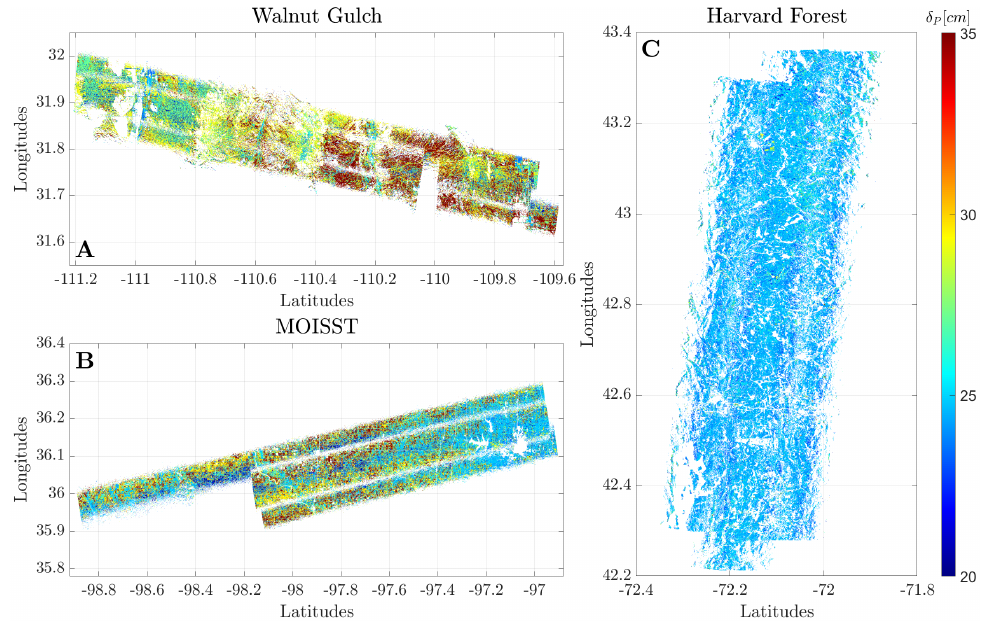
Figure 8. Estimated permittivity-based penetration depth δ P at the AirMOSS monitoring sites. The average values of penetration depths of all dates are displayed (Figure 1, Section 2). White data gaps originate from initial filtering of the input parameters. ( A ) Walnut Gulch, AZ, USA. ( B ) MOISST, OK, USA. ( C ) Harvard Forest, MA, USA.